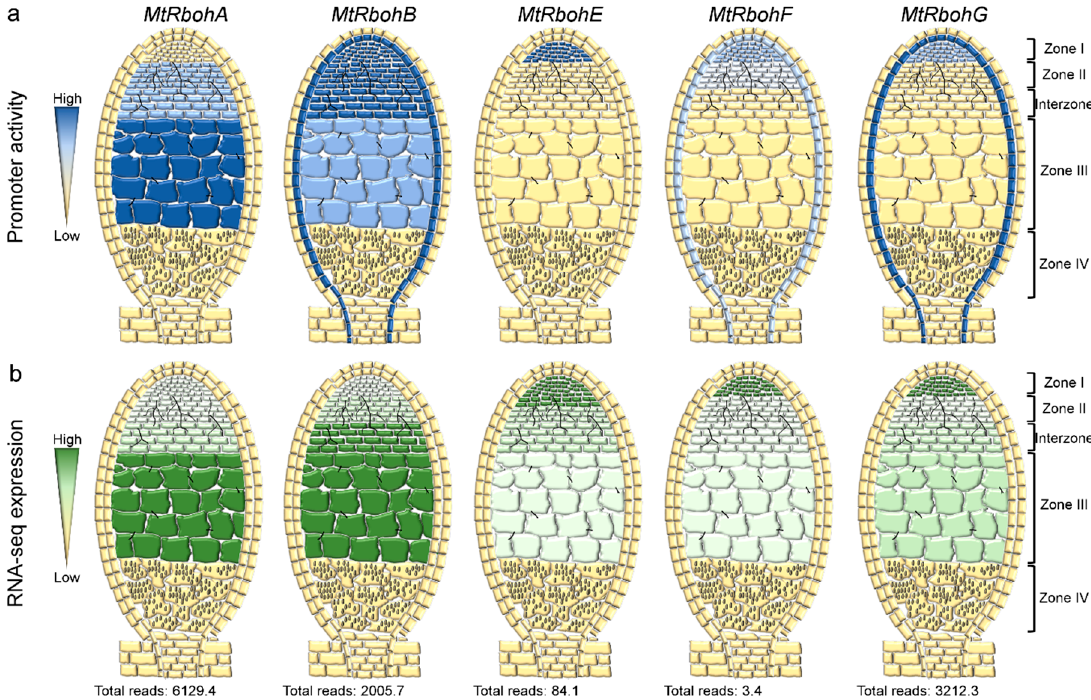
Figure 4. Promoter activity and gene expression of Rbohs in different zones of M. truncatula nodules. A, scheme of the promoter activity (blue staining [8]) ( a ) and RNA-Seq expression profile (green) [34] ( b ) of MtRboh genes in different regions of the nodules suggests the involvement of several MtRbohs in nodule functioning. RNA-Seq analysis was not performed in the senescent cells. Zone I, meristematic region; Zone II, infection zone; Zone III, nitrogen-fixing cells; Zone IV, senescent region.